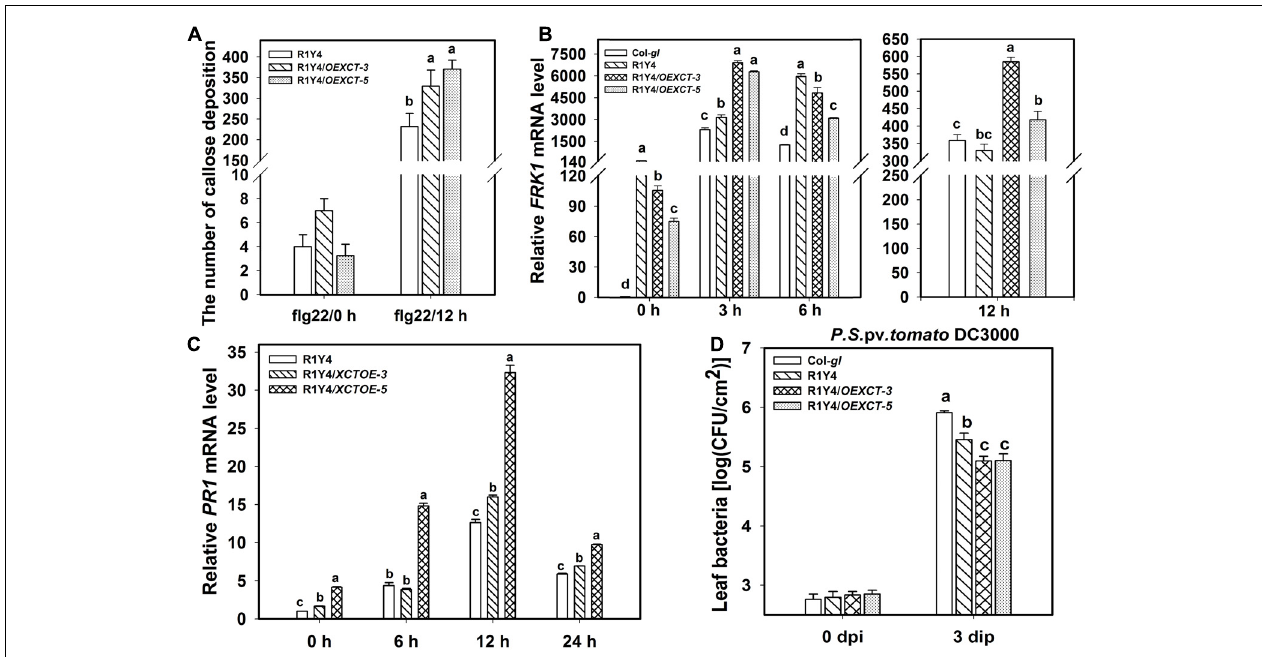
FIGURE 7 | Overexpressing XCT enhances RPW8.1 –mediated defense responses. (A–C) Quantification analysis on the number of callose deposition (A) and the relative level of FRK1 (B) and PR1 (C) induced by flg22 at the indicated time points in the indicated lines. Different letters above the bars indicate significant difference at P < 0.01. (D) Growth of P. syringe DC3000 at the indicated time points on the indicated lines. Error bars indicate SD ( n = 6). Letters above the bars indicate significant differences ( P < 0.01). Similar results were obtained in three independent